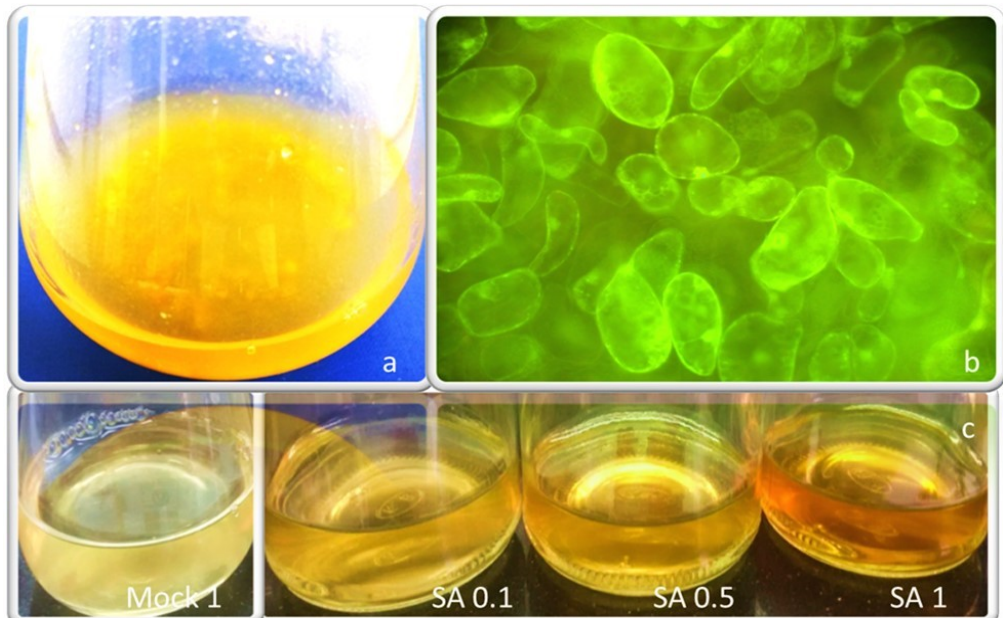
Figure 2. Established sa ff ron cell suspension cultures from style explant in MS medium containing 3 mg L − 1 NAA and 1 mg L − 1 TDZ ( a ); cell viability of untreated (control) sa ff ron suspension culture after staining with fluorescein diacetate ( b ); increasing coloration of the spent medium of sa ff ron treated-cells with increasing SA concentrations ( c ).